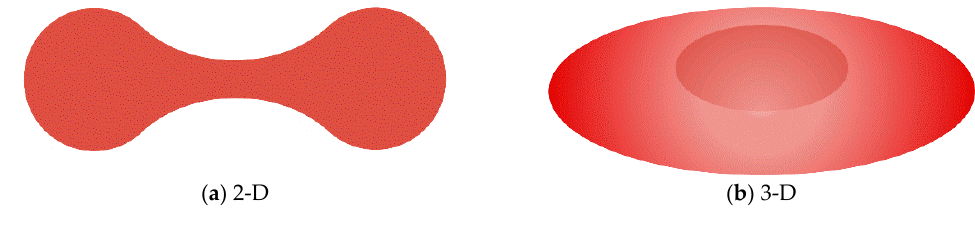
Figure 11. The RBCs model (2-D and 3-D).